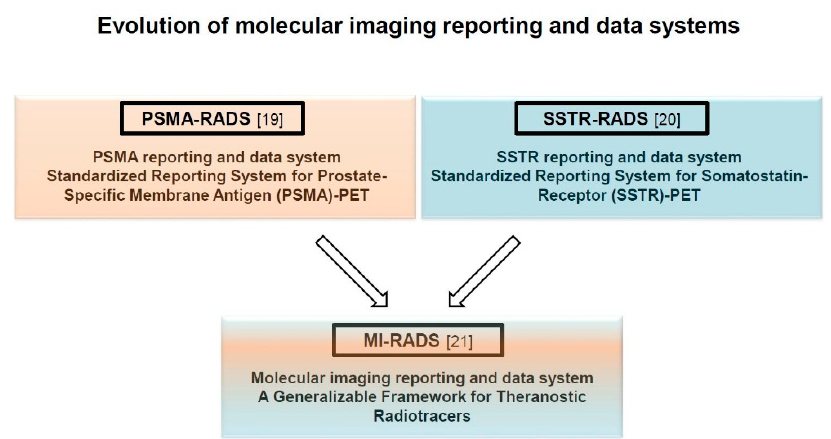
Figure 2. Evolution of molecular imaging reporting and data systems (MI-RADS). For theranostic radiotracers, two novel reporting and data system (RADS) classifications for PSMA- and SSTR-targeted PET imaging (PSMA- and SSTR-RADS) have been summarized under the umbrella term MI-RADS. SSTR: somatostatin receptor; RADS: reporting and data systems.